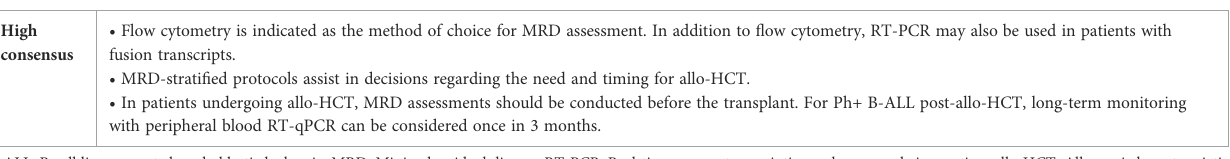
TABLE 4 Expert consensus/recommendations on MRD monitoring in patients with